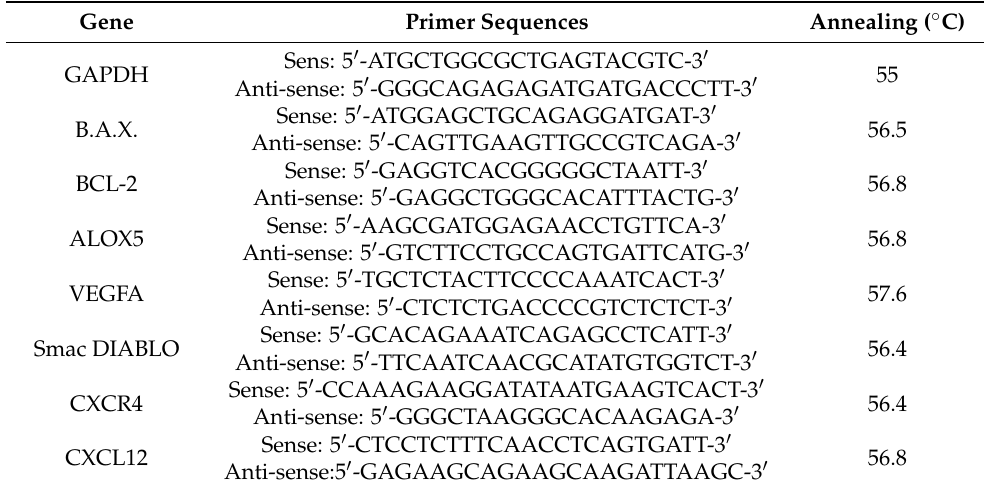
Table 2. Details of the primers used in this